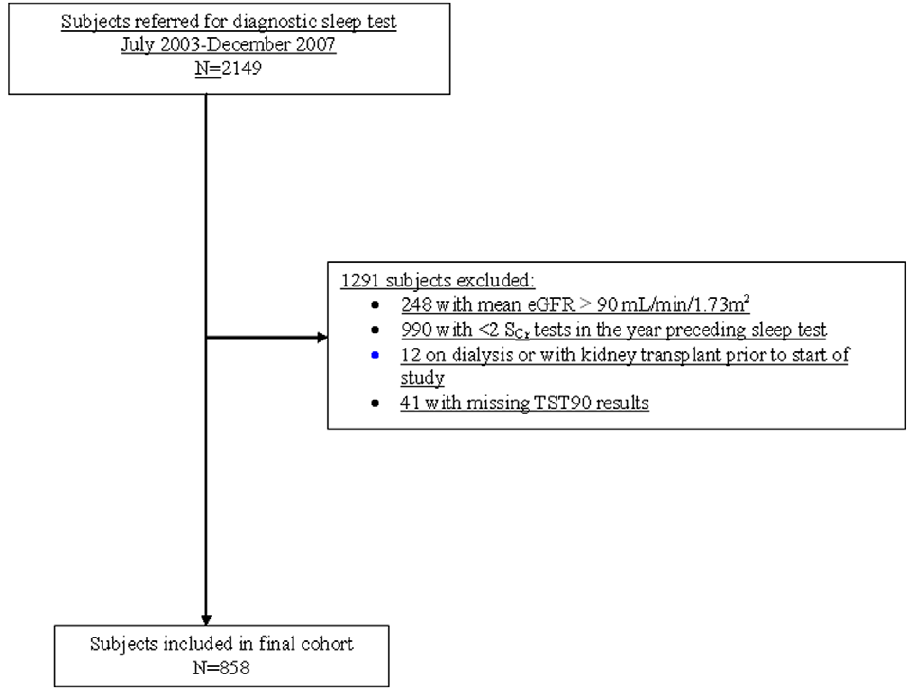
Figure 1. Formation of study cohort and criteria for exclusion. Abbreviations: eGFR, estimated glomerular filtration rate; S Cr , serum creatinine; TST90, total sleep time spent with oxygen saturation , 90%.